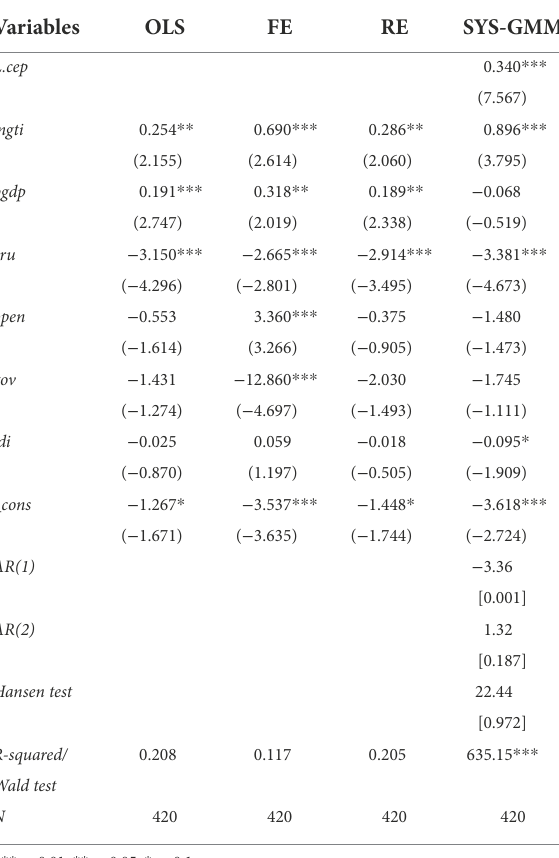
TABLE 8 The robustness test (2). TABLE 7 The robustness test